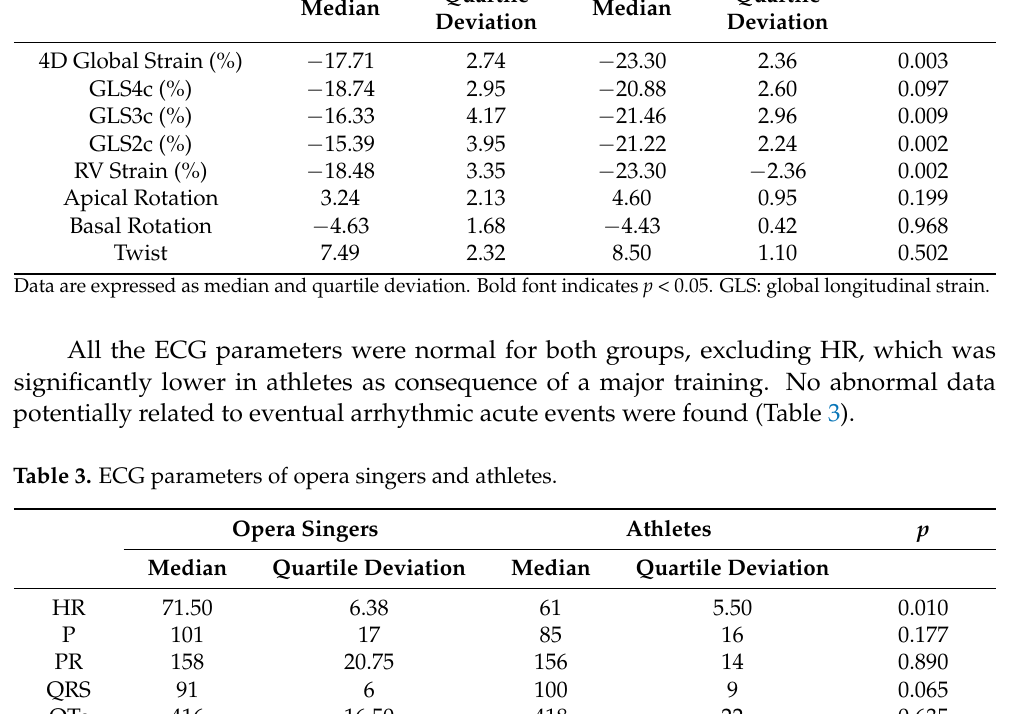
Opera Singers Athletes p Quartile Quartile Median Median Deviation Deviation